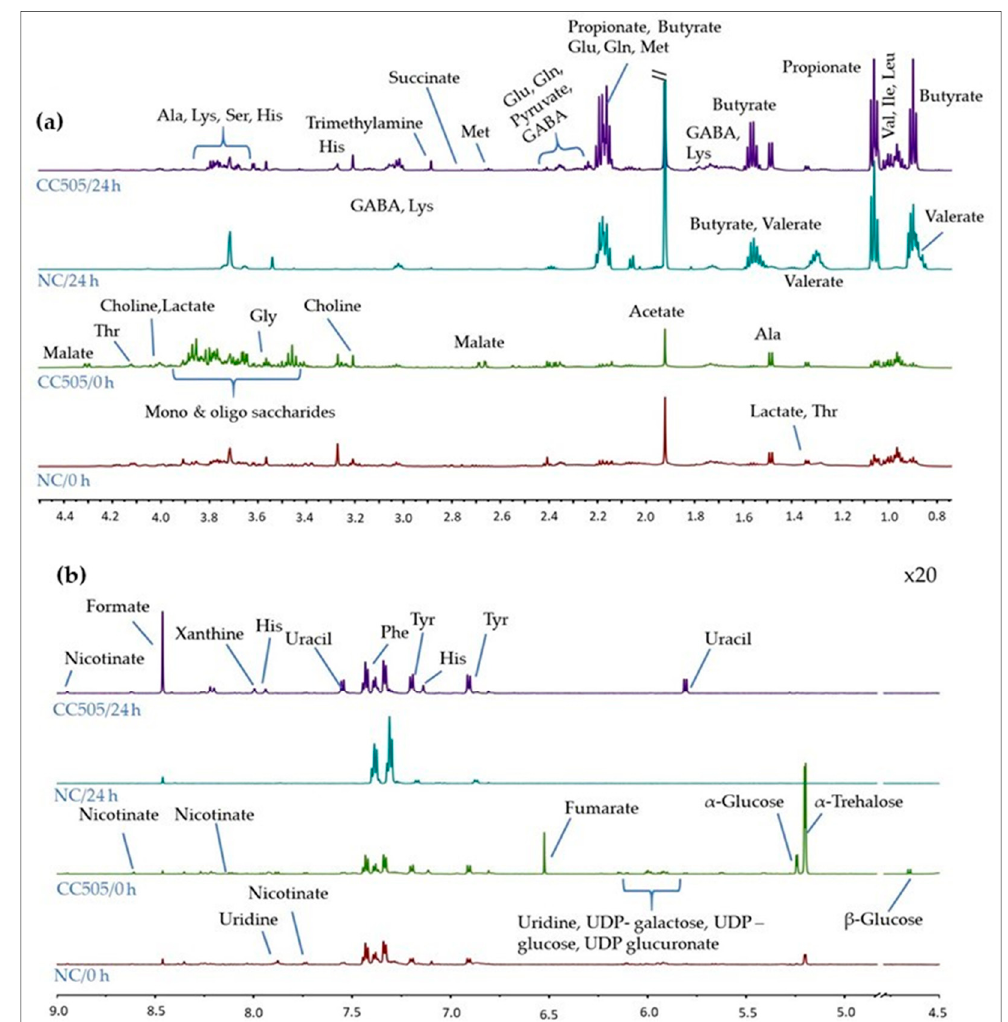
Figure 7. Representative 1 H-NMR spectra of the pre- (t = 0 h) and post-fermentation (t = 24 h) supernatants from one volunteer, for both NC (basal medium with no additional carbohydrate source) and C. cylindracea CC505 ( a ) 0.8–4.4 ppm, and ( b ) 4.5–9.0 ppm. NC: basal medium with no additional carbohydrate source, CC505: C. cylindracea strain 505.